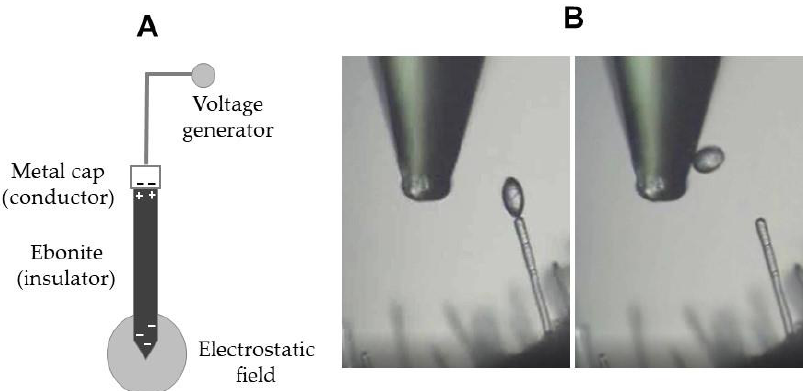
Figure 2. ( A ) Structure of an electrostatic spore collection probe; and ( B ) attraction of a mature spore (conidium) on a tomato powdery mildew conidiophore by an electrostatic spore collection